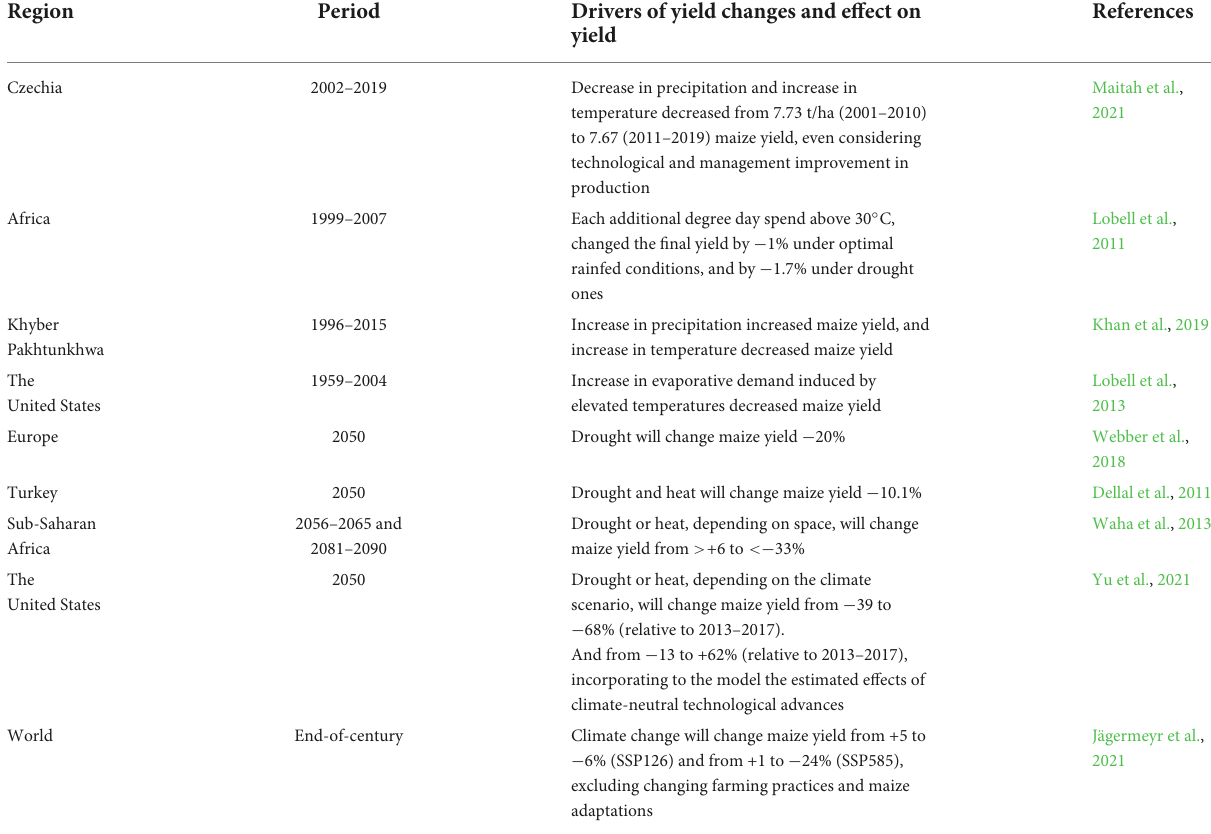
TABLE 1 Observations and estimations of maize yield and drivers of its change. Region Period Drivers of yield changes and effect on